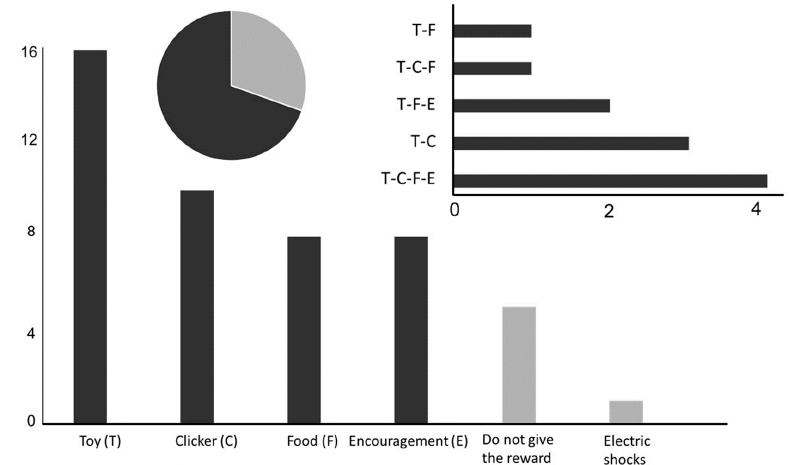
Figure 4. Types of operant conditioning used by the surveyed handlers (y axes, N = 50) to train their human remains detection dogs with the pie chart representing the proportion of reinforcement and punishment technics used (light grey: punishment, dark grey: reinforcement).